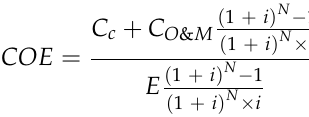
Figure 9. Percentage of capital costs for three PRO power plants.